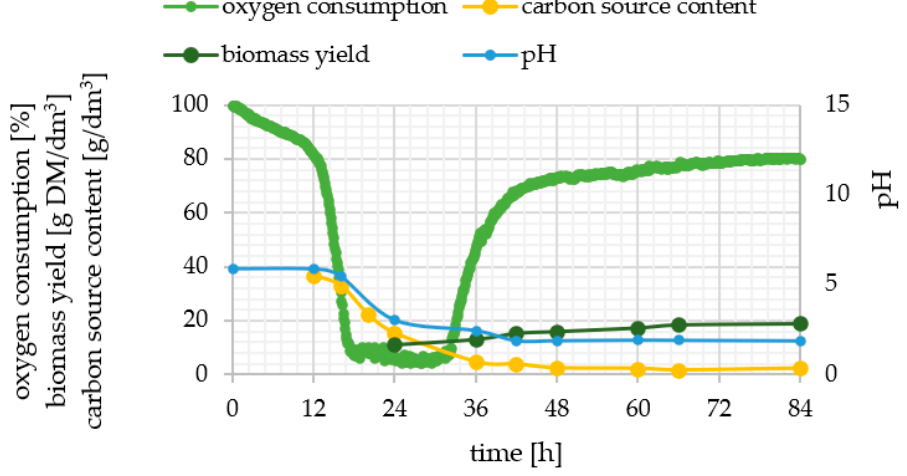
Figure 3. Changes in pH (thick light line), relative oxygen consumption (thick dark line), biomass yield (thin dark line) and carbon source content (thin light line; glucose or olive oil) during batch cultures of Y. lipolytica KKP 379 strain in MO5-2xN medium.